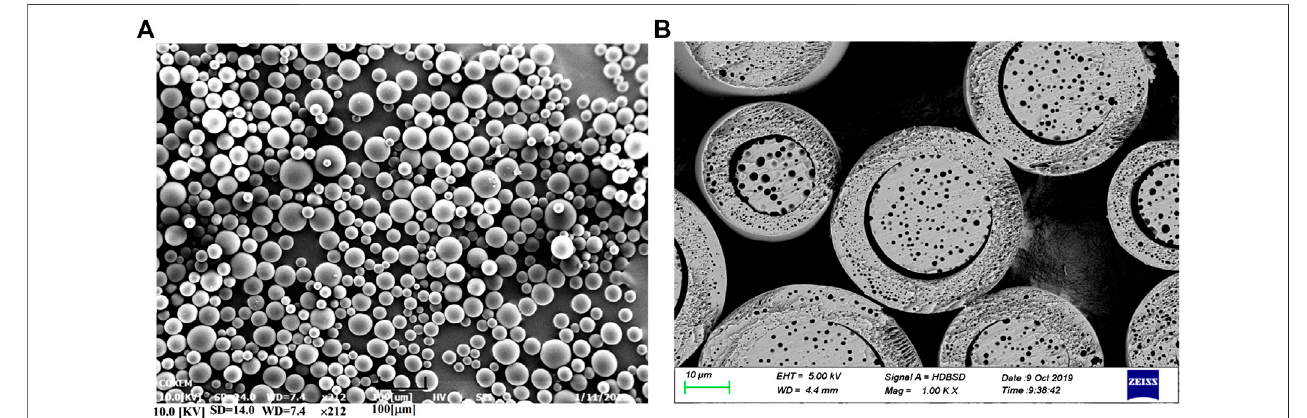
FIGURE 4 | SEM images of GLT-PM-MS. (A) : the surface morphology, (B) : the cross-section morphology.